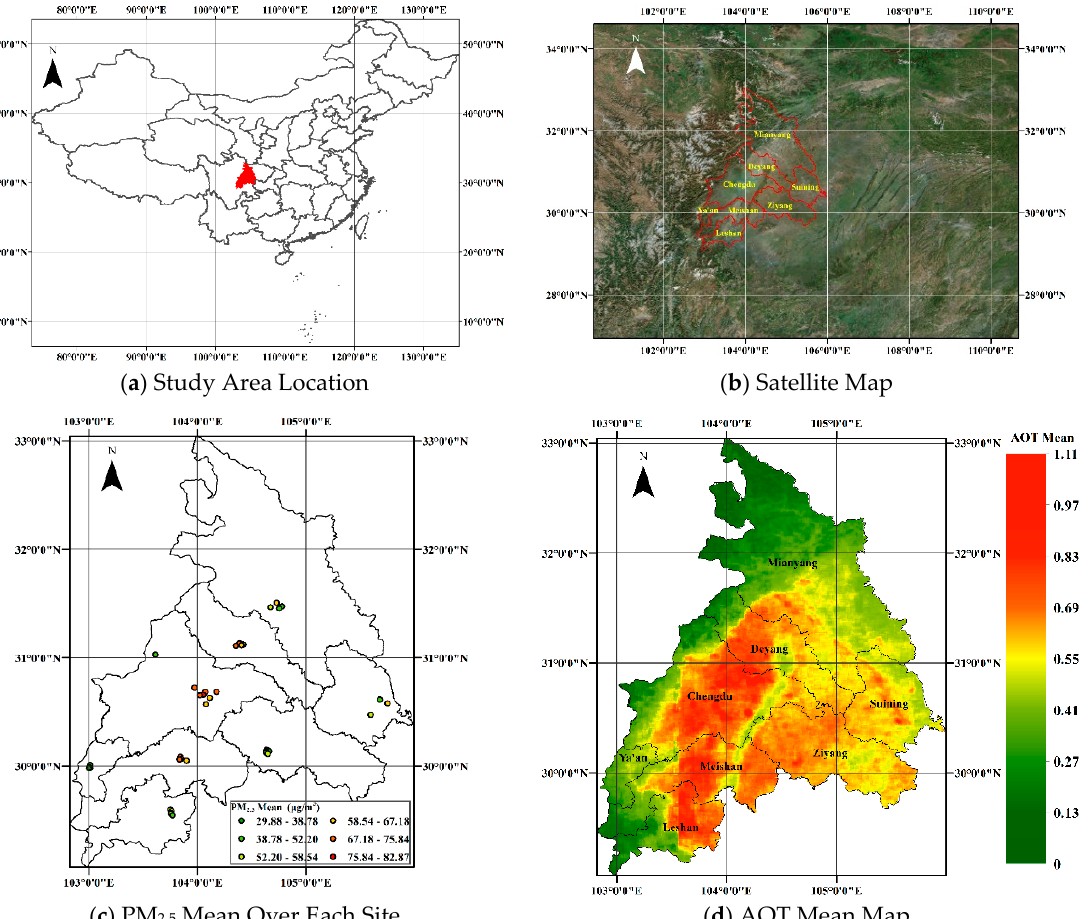
Figure 1. ( a ) Study area location at China (displayed with red polygon in the map); ( b ) satellite map shows that study area (red lines) is surrounded by mountains in the west, north, and northeast (Satellite imagery source: Esri, DigitalGlobe, GeoEye); ( c ) annual average PM 2.5 24-h average ( µ g / m 3 ) for each site, which is classified into six levels represented by di ff erent color; ( d ) the spatial distribution of average of multi-angle implementation of atmospheric correction (MAIAC) aerosol optical thickness (AOT) at 1 km resolution during 2015. The boundaries of eight province-controlled cities are shown in black